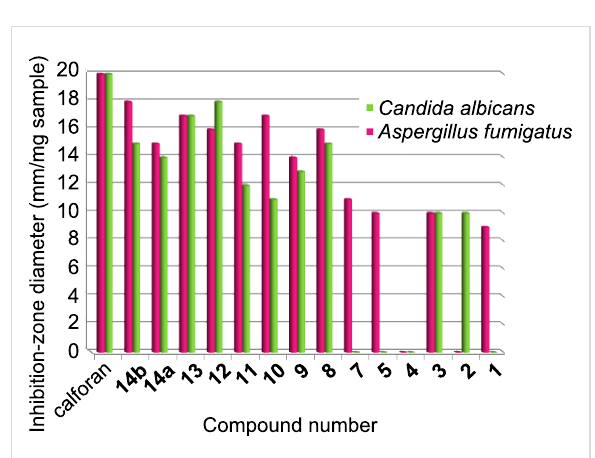
Figure 2: Graphical representation of antifungal activity of tested com- pounds, compared to